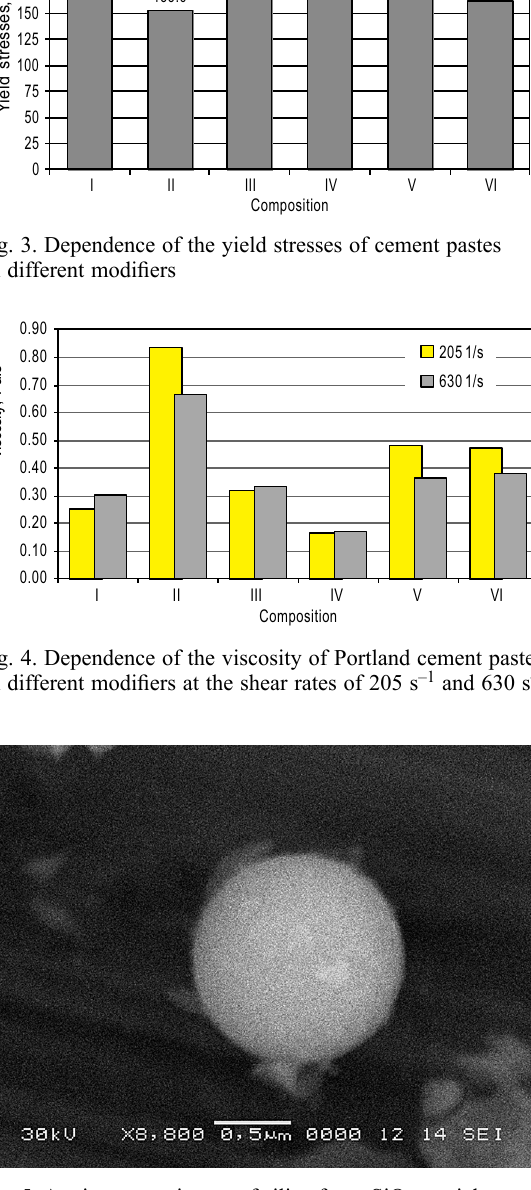
Fig. 5. A microscopy image of silica fume SiO 2